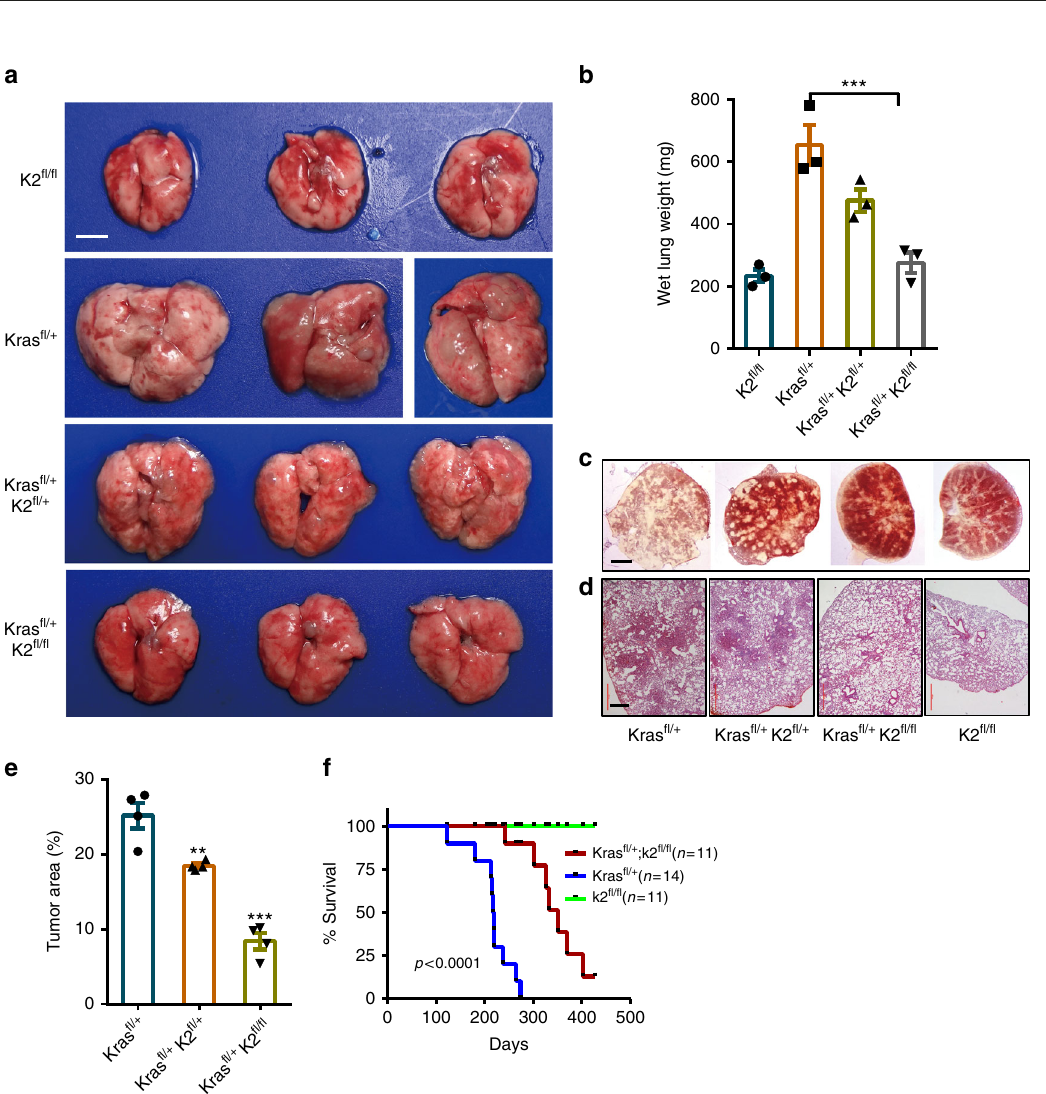
Fig. 8 Elevated levels of kindlin-2, PYCR1, and tissue stiffness in lung adenocarcinoma. a – d Human lung adenocarcinoma (LAC) and normal adjacent lung tissues (NAT) were stained with kindlin-2 ( a ) or PYCR1 ( b ) antibodies as indicated. Red arrows indicate tumor regions. Scale bar, 20 μ m. Kindlin-2 ( c ) and PYCR1 ( d ) immunohistochemical (IHC) staining of human lung adenocarcinoma and normal adjacent lung tissues was quanti fi ed as described in the Methods. Lung adenocarcinoma, n = 24; normal adjacent lung tissue, n = 8. *** P < 0.001. e – j Lung adenocarcinoma was induced by administration of Ad- Cre into the lung of Kras LSL − G12D / + mice. Sixteen weeks later, lung tissues from the Kras LSL − G12D / + mice administrated with Ad-Cre ( e , lower panel) or without Ad-Cre as a control ( e , upper panel) were shown. Scale bar, 500 μ m. f Sections from areas of the tissues shown in e (as indicated in the fi gure) were analyzed by immunostaining with anti-PYCR1 and kindlin-2 antibody ( f ) and atomic force microscopy ( g – j ). Scale bar in f = 20 μ m. Stiffness mapping of tissues are shown in g ; force (nN) vs. indentation depth (nm) graph highlighting the raw data and fi tting by the Sneddon model to extract the tissues ’ elastic moduli ( h ). Quantitative analysis using histograms of Young ’ s modulus values in log-normal scale with a Gaussian distribution fi t ( i ) and Young ’ s moduli ( j , n = 6 distinct locations that are macroscopically distant from each other) of the health lung tissue, lung adenocarcinoma (LAC), and normal tissue adjacent to the tumor (NAT) were analyzed as described in the Methods. Data in c , d , j are presented as mean ± SEM using one-way ANOVA with Tukey – Kramer post-hoc analysis ( j ) or two-tailed unpaired Student ’ s t-test ( c , d ), *** P